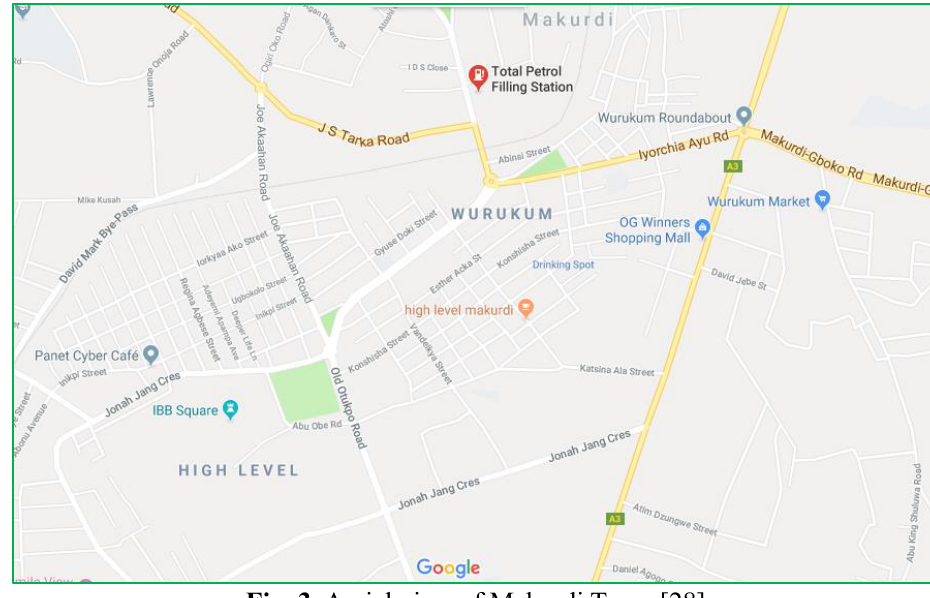
Fig. 3. Aerial view of Makurdi Town